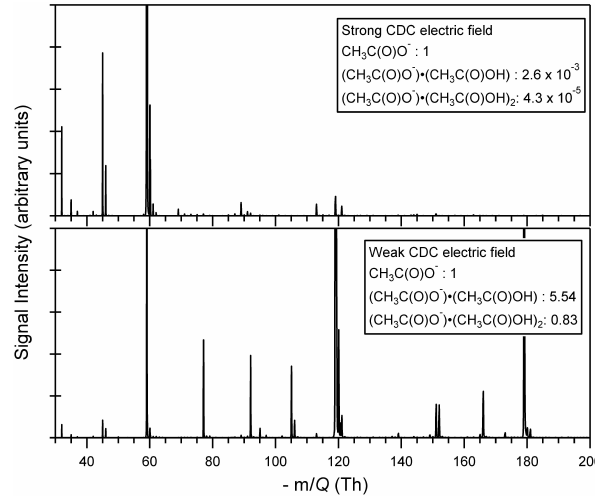
Fig. 2. Sample mass spectrum taken at 2Hz on ambient air using the two declustering schemes shown in Fig. 1b. In a strong CDC electric field, acetate ions are primarily observed as bare ions (top), while in a weak CDC electric field acetate can be observed in sig- nificant quantities in both the (CH 3 C(O)O − ) · (CH 3 C(O)OH) clus- ter ( − 119.034Th) and the (CH 3 C(O)O − ) × (CH 3 C(O)OH) 2 clus- ter ( − 179.055Th) (bottom). The ratio of the cluster ion count rate to the bare ion count rate is shown in the figure